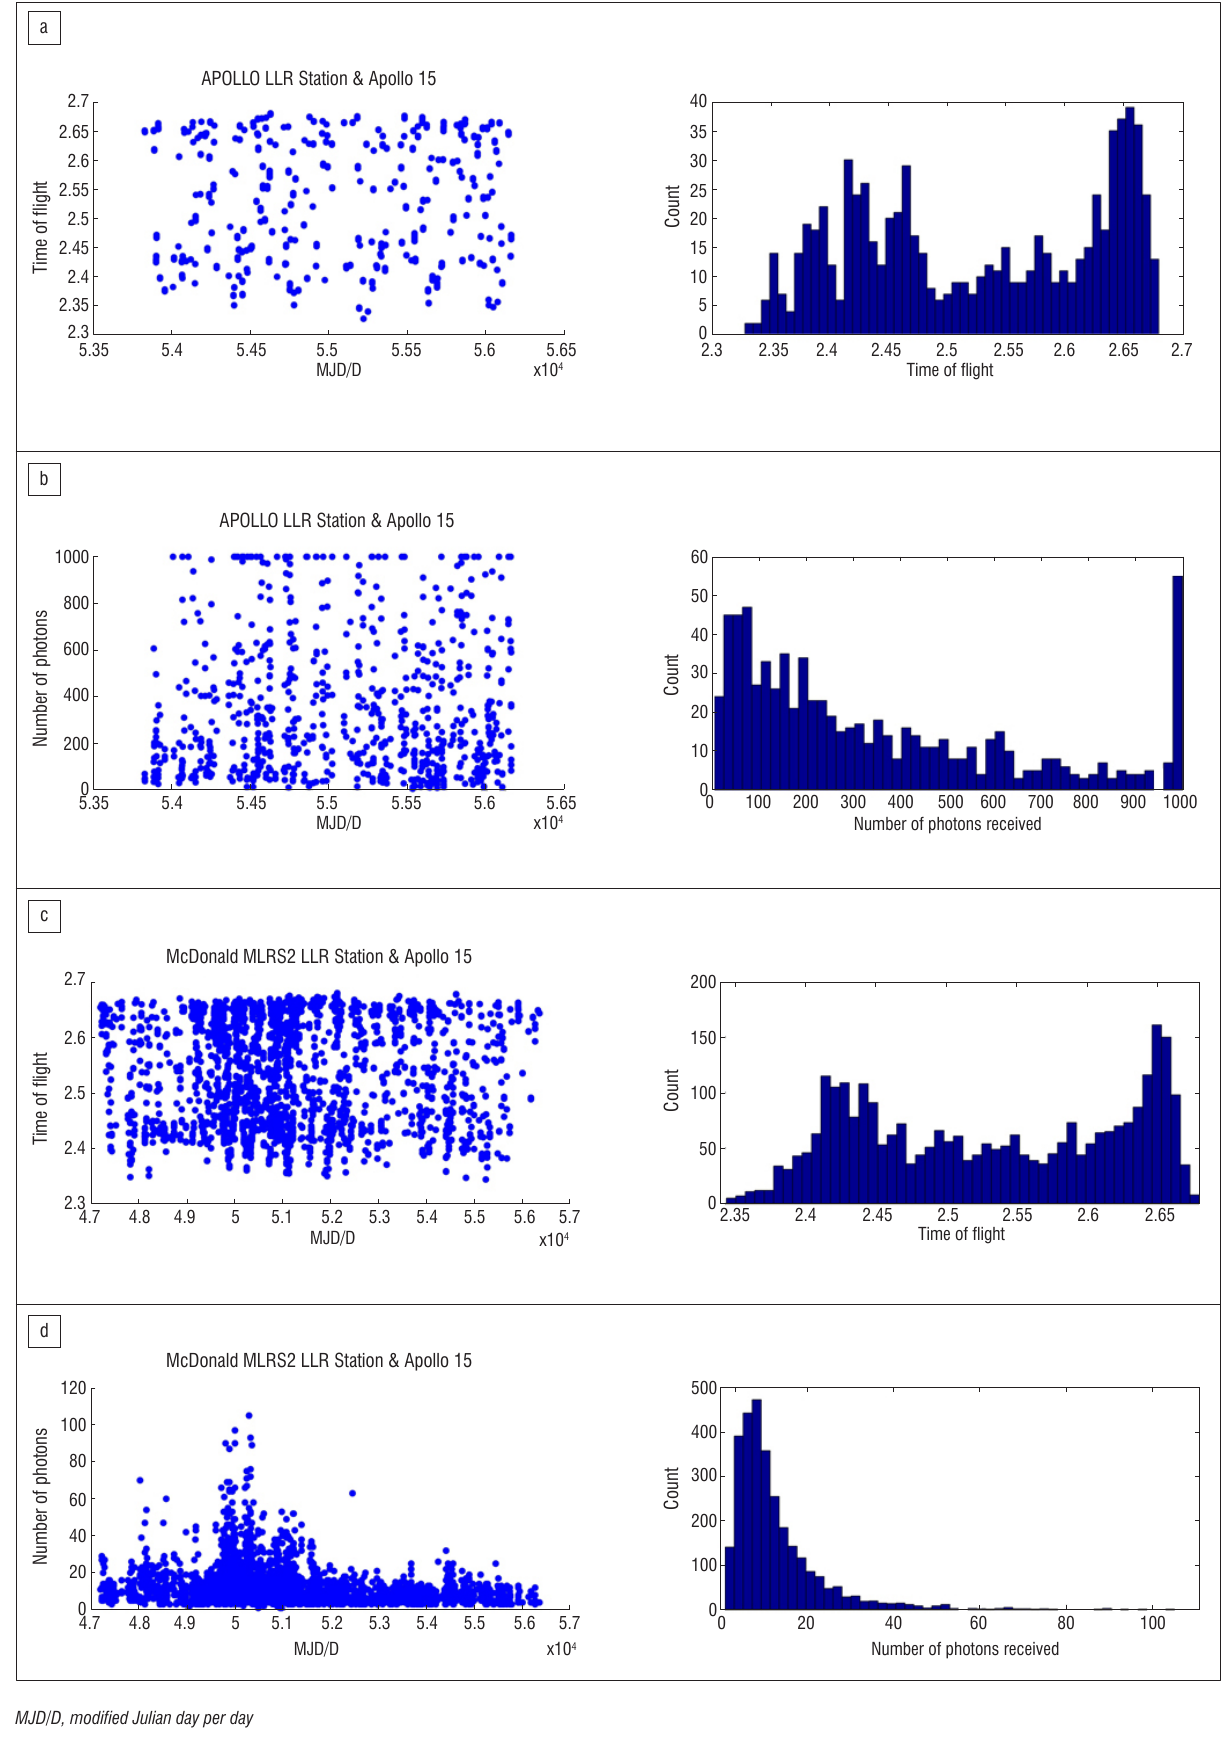
Figure 3 : (a,c) Time-of-flight and (b,d) received number of photons measured between the Apollo 15 retroreflector on the moon and the APOLLO and McDonald MLRS2